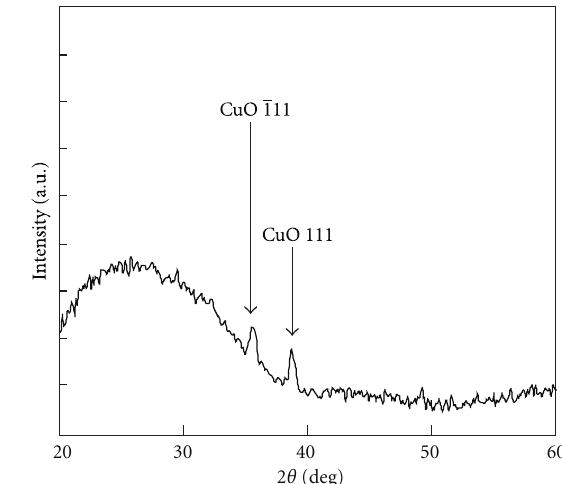
Figure 7: XRD patterns of CuO thin films annealed at 300 ◦ C for 3 hours in air.